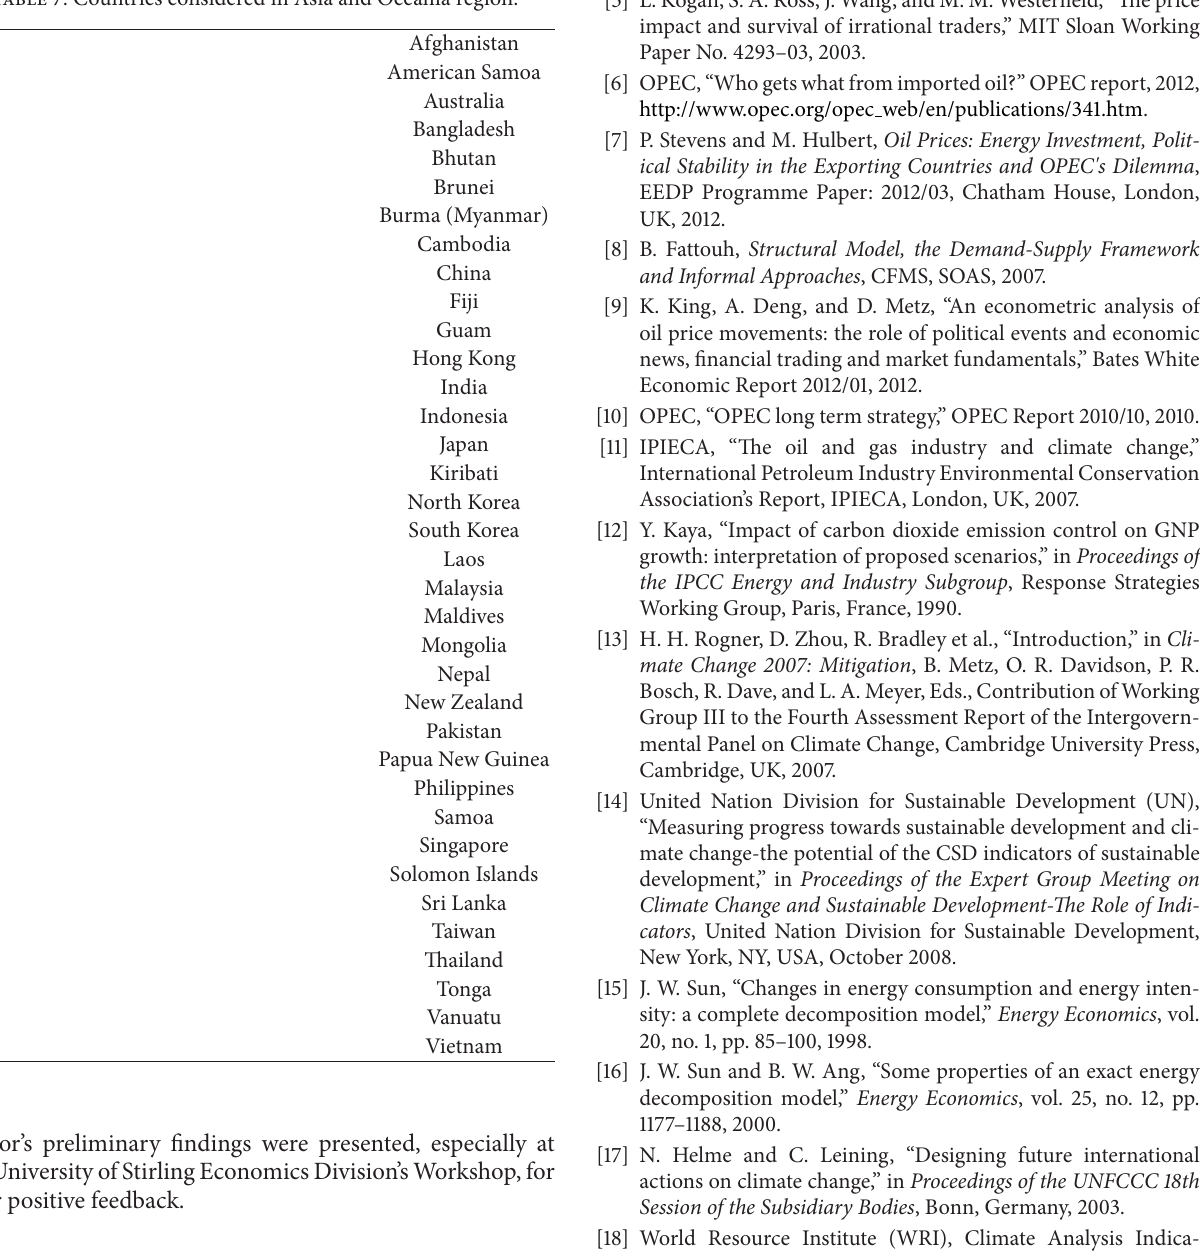
Table 7: Countries considered in Asia and Oceania